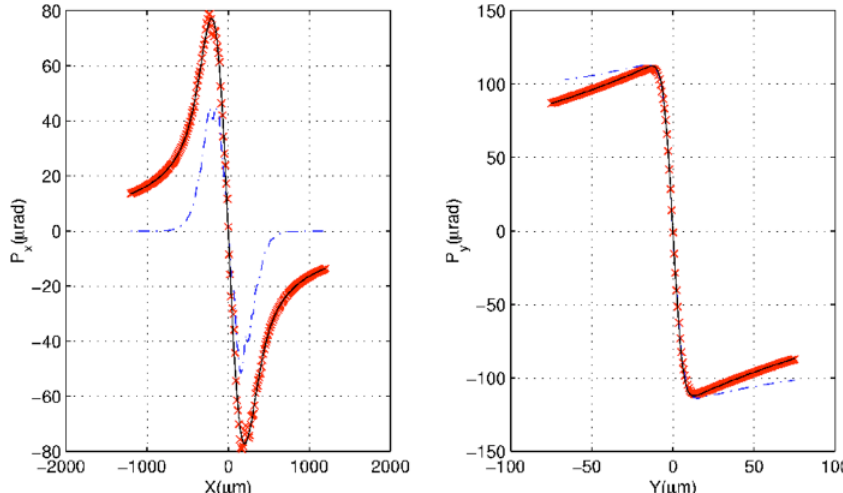
FIG. 2. (Color) The beam-beam kick by a flat Gaussian beam with aspect ratio 30:1 near the x and y axes. The dash-dotted curve is the case when f (cid:1) 0 is assigned as the boundary condition. The “ 3 ” is the kick when the inhomogeneous boundary condition is used. The solid curve is the kick produced by the Erskine-Bassetti formula